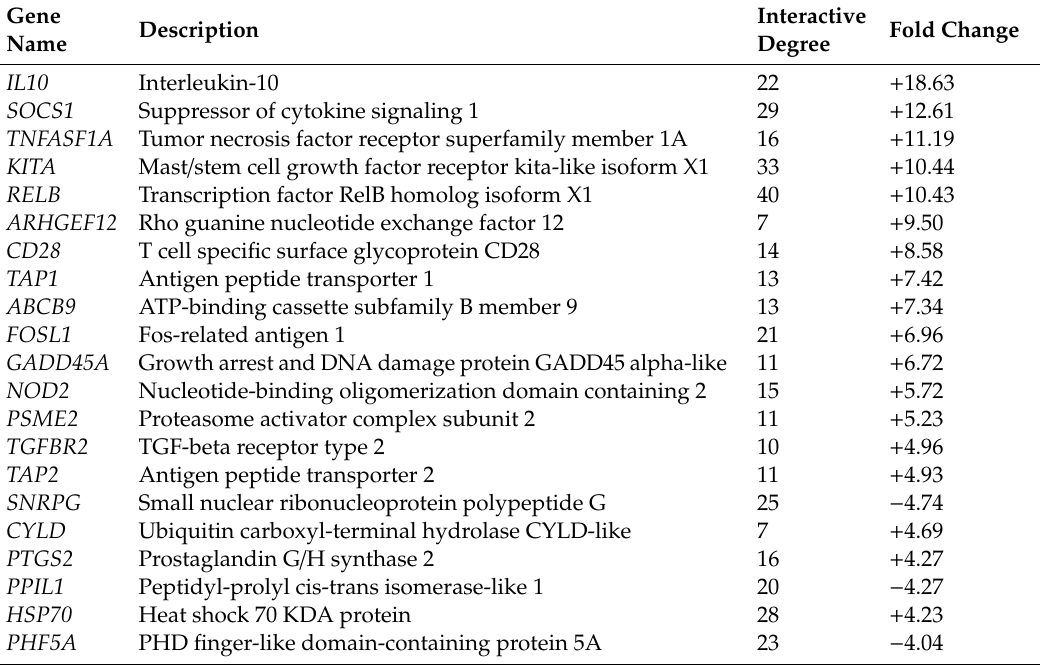
Table 3. Summary of the 21 hub DEGs. The “ + ” and “–” symbols before the fold change number indicate up- and downregulation,